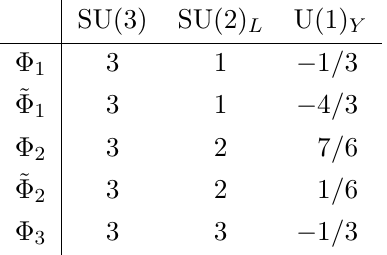
Table 1 . The five possible scalar leptoquark representations under the SM gauge